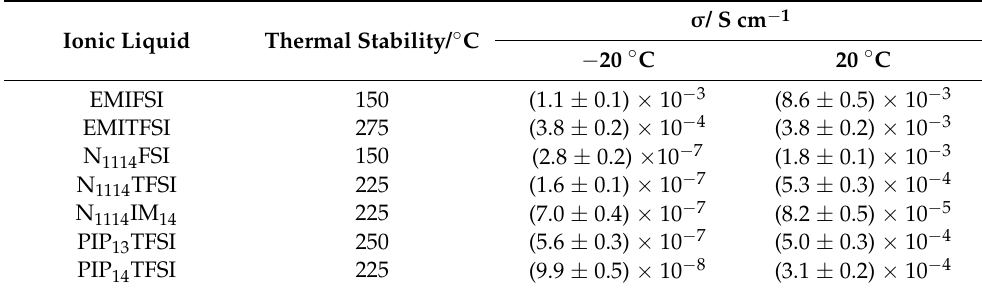
Table 1. Thermal stability and ionic conductivity ( σ ) values of 0.1NaTFSI-0.9IL electrolytes. The data are taken from ref.